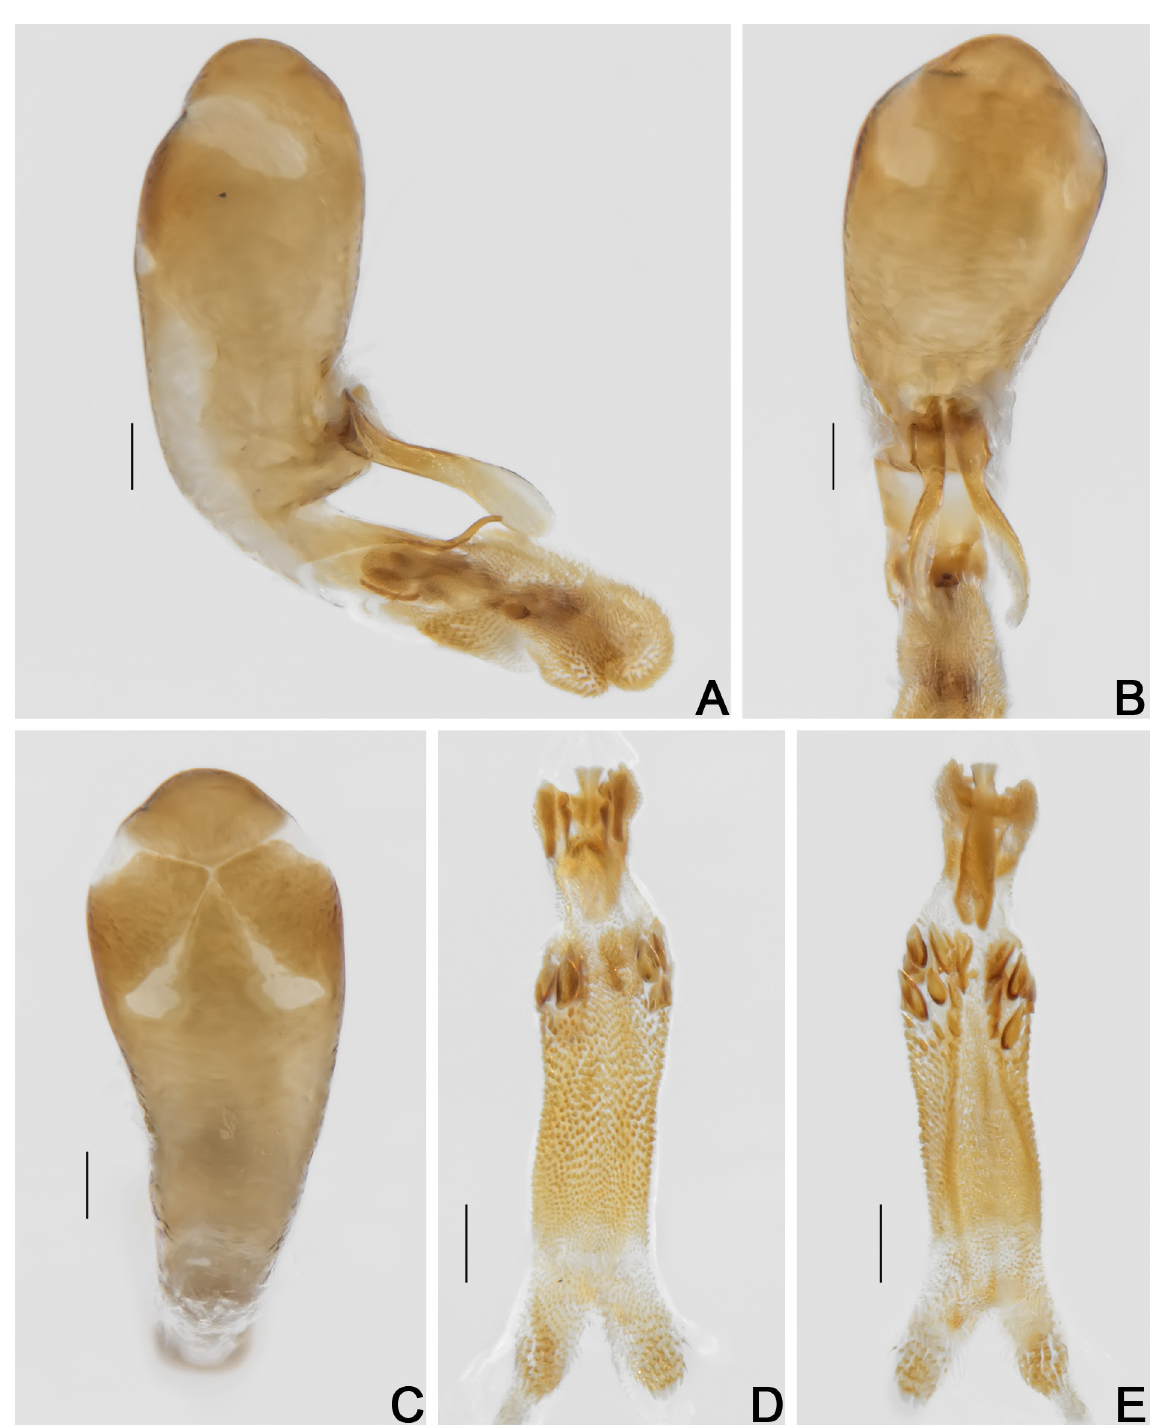
Fig. 20. Cyparium lescheni sp. nov., paratype, ♂ (CELC). A–C . Aedeagi. A . Lateral view. B . Frontal view. C . Dorsal view. D–E . Internal sac. D . Frontal view. E . Dorsal view. Specimen collected at Mata da Biologia, Viçosa (MG, Brazil). Scale bars = 0.1